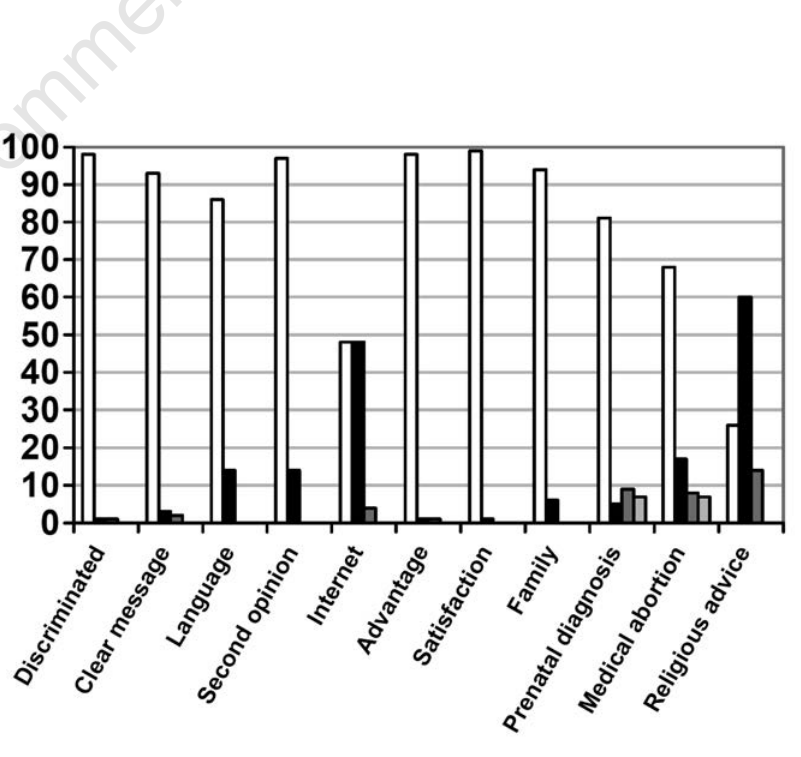
Figure 5. Additional positive (white) and negative feelings (black) registered at level 2. Missing answers are in grey may be answers (not sure) are in light